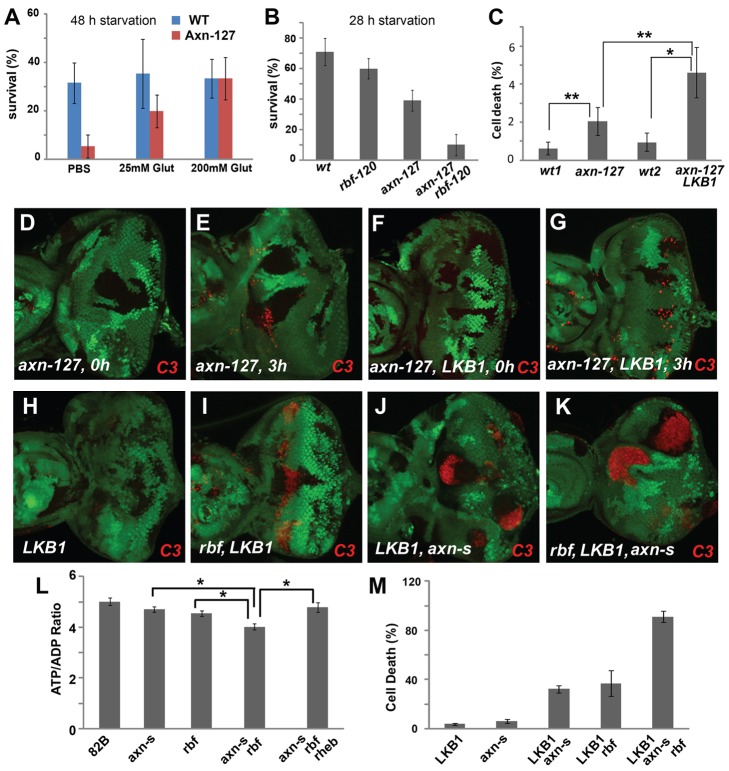

axn mutants are hypersensitive to fasting and energy deficiency.(A) Compared to the FRT 82 controls, fewer axn127 mutant larvae survived after starvation in PBS for 48 hours, and addition of glutamine to PBS largely rescued the lethality of the axn127 mutant larvae (p = 0.0002 for PBS vs 25 mM Gln and p<0.0001 for PBS vs 100 mM Gln). (B) With 28 h starvation, survival rates of rbf120 larvae or axn127 larvae were lower than WT larvae, and rbf120 axn127 double mutant larvae were much more sensitive to fasting than single mutant larvae (P<0.001 for axn127 VS rbf120 axn127). (C) Quantification of cell death in eye discs fasted for 3 hours. In developing eye discs with mosaic mutant clones, discs without fasting showed very low level of apoptosis in both wild type tissues and axn127 or lkb1 axn127 mutant clones (D and F). Discs fasted for 3 hours had increased apoptosis in both wild type tissues and mutant mosaic clones (E and G), which are quantified in (C). The level of apoptosis in axn127 or lkb1 axn127 clones with fasting was significantly higher than surrounding wild type cells (p = 0.0015 for WT vs axn127 and p<0.0001 for WT vs lkb1 axn127), and lkb1 axn127 mutant cells have more apoptosis than axn127 mutant cells (P<0.002) (C). lkb1 single mutant did not show significant level of apoptosis (H), lkb1 rbf or lkb1 axnS mutations induced synergistic apoptosis (I–J), and lkb1 axnS rbf triple mutant cells had very high levels of apoptosis (K). Quantification of C3 levels in (H–K) is shown in panel (M). The ATP/ADP ratio of eye discs with axnS, axnS rbf, or axnS rbf rheb mutant clones induced in Minute background were determined (L). Comparing to wild type cells (FRT 82B), axnS mutant cells had slightly lower ATP/ADP ratio (p<0.01); the ATP/ADP ratio of axnS rbf mutant cells was significantly lower than that of the axnS or rbf mutant cells (p<0.0001); the ATP/ADP ratio of axnS rbf rheb mutant cells was similar to that of the axnS mutants (p = 0.4, between axnS and axnS rbf rheb) (L). * and ** indicate p<0.0001 and p<0.002, respectively.